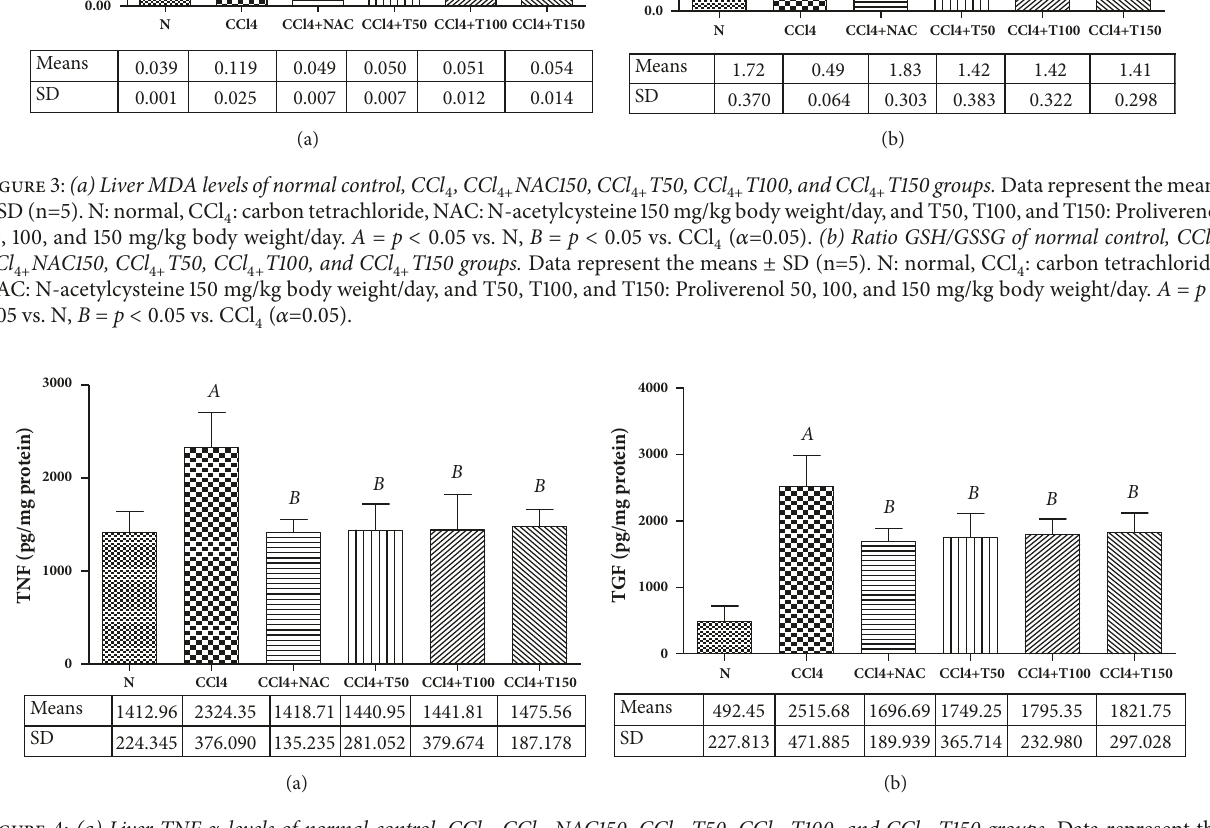
Figure 4: (a) Liver TNF- 𝛼 levels of normal control, CCl 4 , CCl 4+ NAC150, CCl 4+ T50, CCl 4+ T100, and CCl 4+ T150 groups. Data represent the means ± SD (n=5). N: normal, CCl 4 : carbon tetrachloride, NAC: N-acetylcysteine 150 mg/kg body weight/day, and T50, T100, and T150: Proliverenol 50, 100, and 150 mg/kg body weight/day. A = p < 0.05 vs. N, B = p < 0.05 vs. CCl 4 ( 𝛼 =0.05). (b) Liver TGF- 𝛽 1 levels of normal control, CCl 4 , CCl 4+ NAC150, CCl 4+ T50, CCl 4+ T100, and CCl 4+ T150 groups. Data represent the means ± SD (n=5). N: normal, CCl 4 : carbon tetrachloride, NAC: N-acetylcysteine 150 mg/kg body weight/day, and T50, T100, and T150: Proliverenol 50, 100, and 150 mg/kg body weight/day. A = p < 0.05 vs. N, B = p < 0.05 vs. CCl 4 ( 𝛼